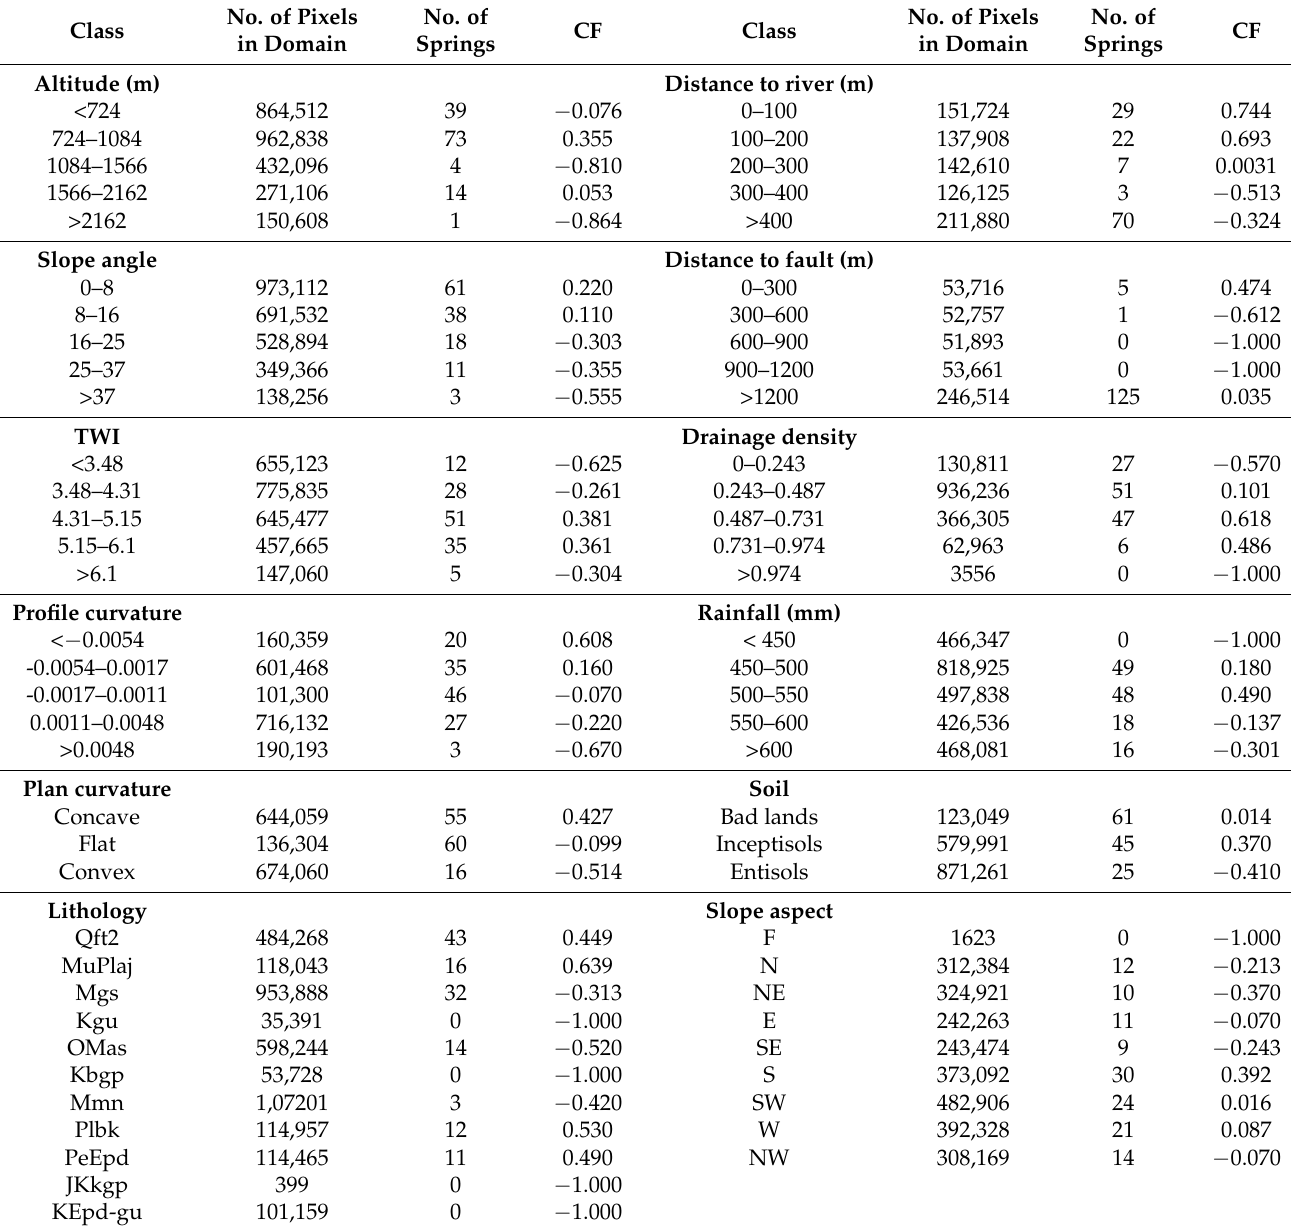
Table 1. Results of the CF